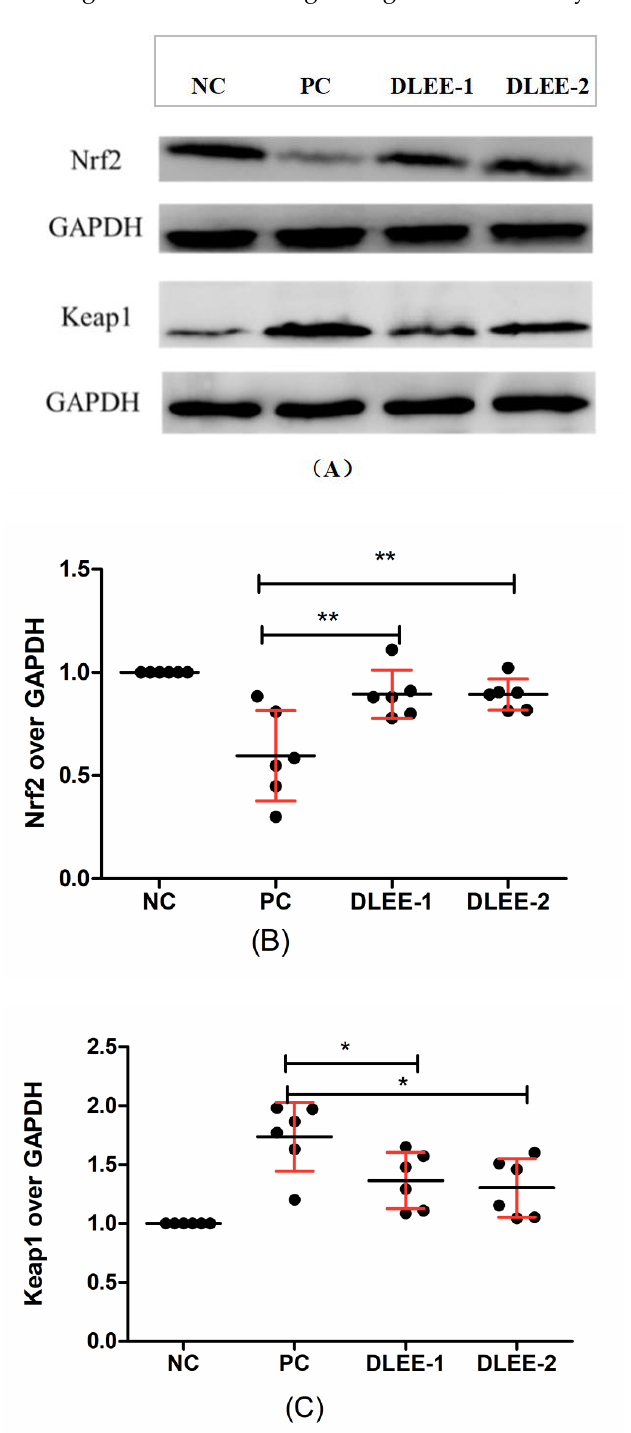
Figure 5. The cellular expression of Nrf2 and Keap1 in Caco-2 cells following a pretreatment with DLEE. ( A ) Nrf2 and Keap1 expressions in RAW264.7 cells; ( B ) Quantification of Nrf2; ( C ) Quantifica- tion of Keap1 expression. NC, negative control group without any treatments; PC, H 2 O 2 -induced pos- itive control group (1 mM, 2 h); DLEE-1 and DLEE-2 represent pretreatment with 1.0 and 1.5 mg/mL DLEE (2 h) before H 2 O 2 -induced stimulation. Data are presented as the means ± SD ( n = 6) and *, **, represent significant differences with p < 0.05, p < 0.01,